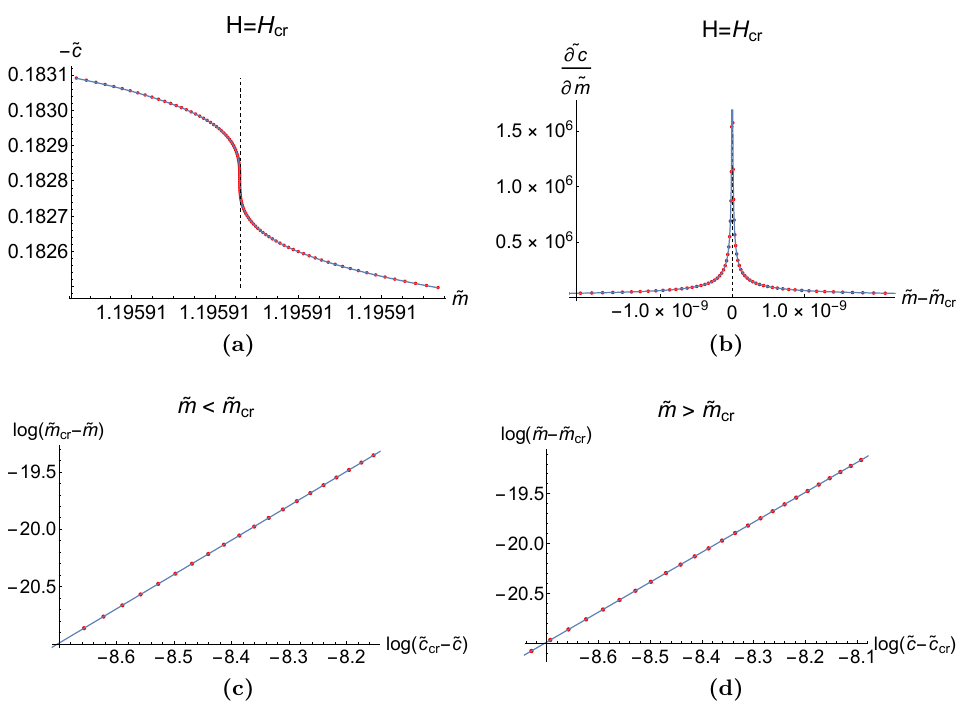
Figure 6. (a) A plot of ~ c versus ~ m zoomed in near ~ m cr , ~ c cr . (b) A plot of the susceptibility ~ c= ~ m (cid:0) versus ~ m ~ m cr near the critical region. (c) A plot of log( ~ m cr (cid:0) (d) A plot of log( ~ m ~ m cr ) versus log(~ c ~ c cr ) for ~ m > ~ m cr (cid:0) (cid:0)